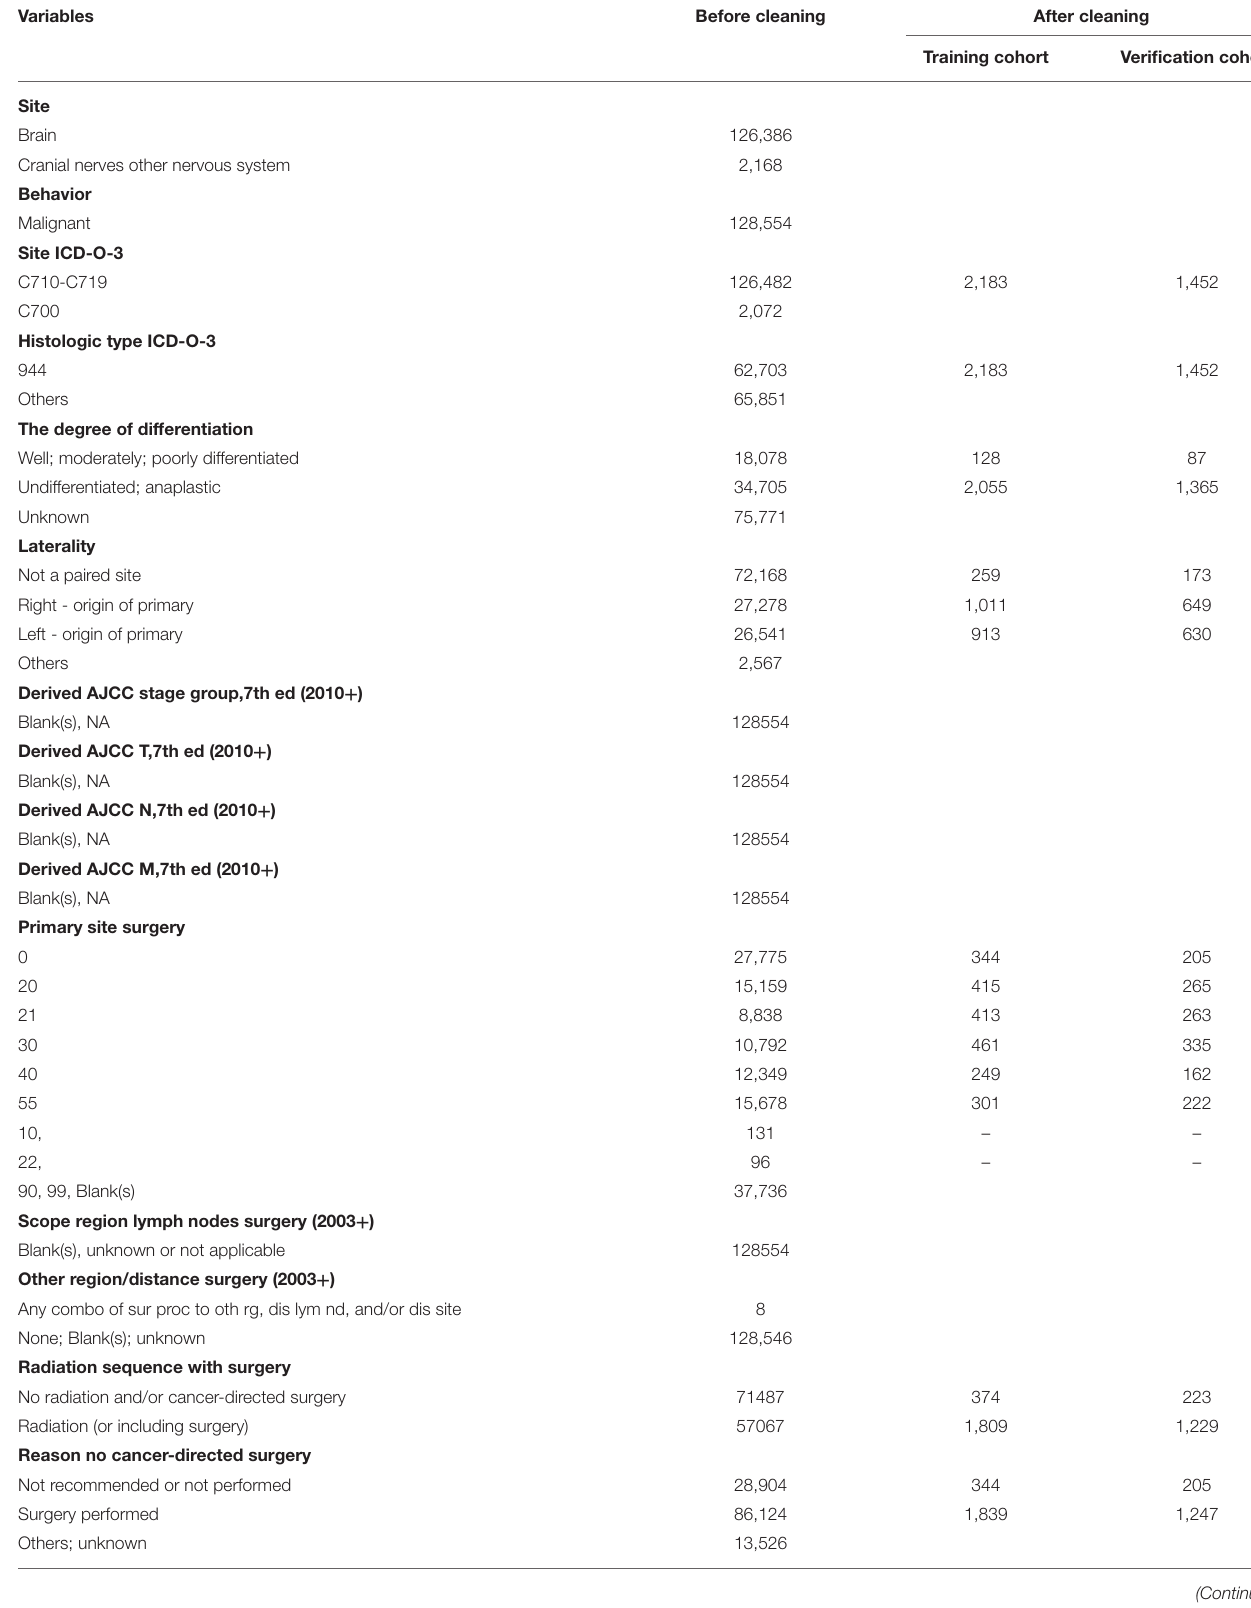
TABLE 2 | Cleaning of patient clinical and diagnostic data.